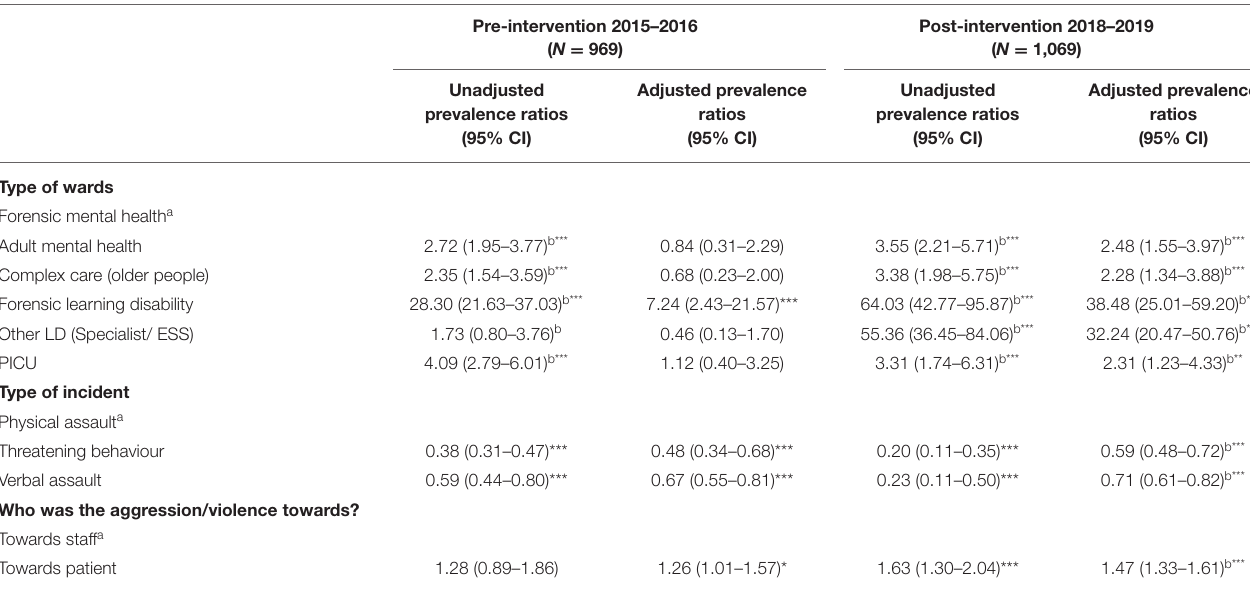
TABLE 5 | Prevalence ratio associated with